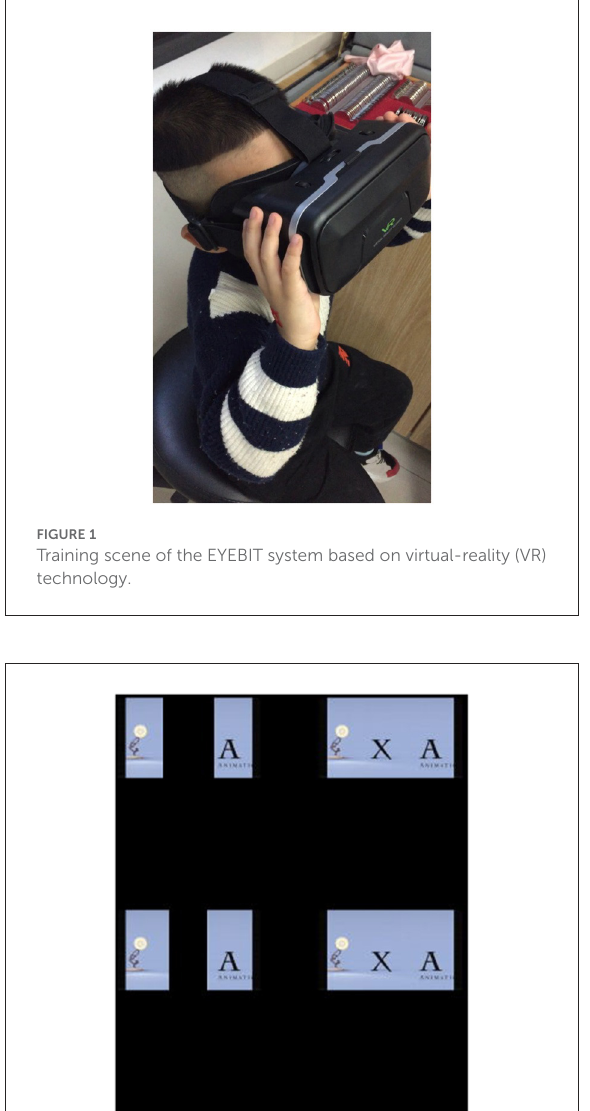
FIGURE2 Comparison chart after adding four masks of different degrees to the left eye window.